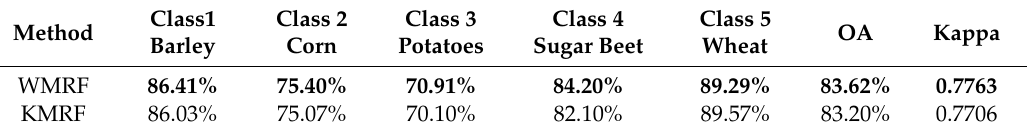
Table 4. Comparison of the region-based classification algorithms for the Wallerfing